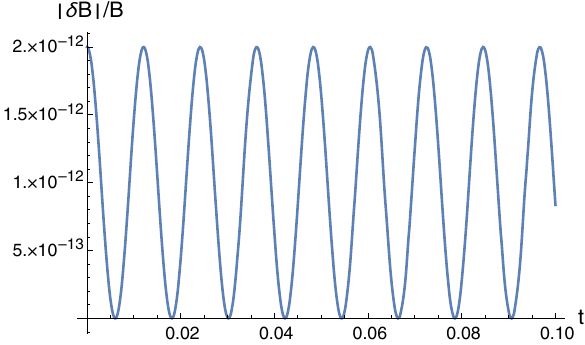
Fig. 4 Here we see the strength of the magnetic fluctuation induced by the GW as a function of time (in seconds). In the vertical axis we have the non-dimensional quantity |(cid:11) B GW (cid:11) − (cid:11) B 0 (cid:11)| / (cid:11) B 0 (cid:11) , where B GW = ( B x , B y ) is the magnetic field in the presence of the passing GW,obtainedfromEqs.(3.48)and(3.49),and B 0 isthecontrolmagnetic field in the case without GW. The GW parameters are a = 2 . 0 × 10 − 6 , w/ 2 π = 41 . 38